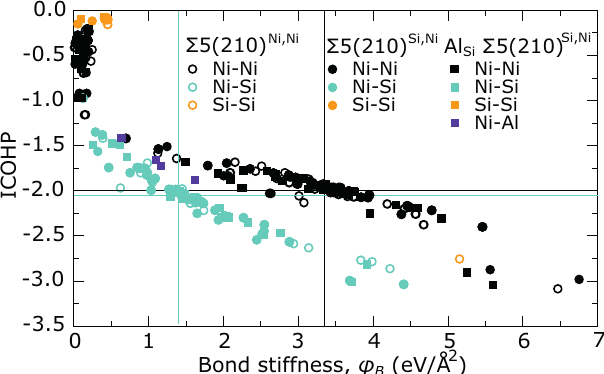
Figure 6. Integral of COHP up to the Fermi level as a function of projected force constant ϕ B (bond stiffness) for Σ 5(210) Ni,Ni GB (open circles), Σ 5(210) Si,Ni GB (full circles) and Σ 5(210) Si,Ni GB with Al (full squares). Black solid lines correspond to values for nearest neighbors Ni–Ni bond in bulk Ni 3 Si, whereas cyan solid lines represent Ni–Si